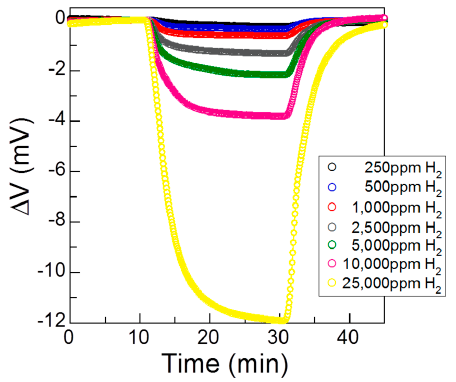
Figure 3. Sensor response to different concentrations of H 2 in humid air at 120 °C.